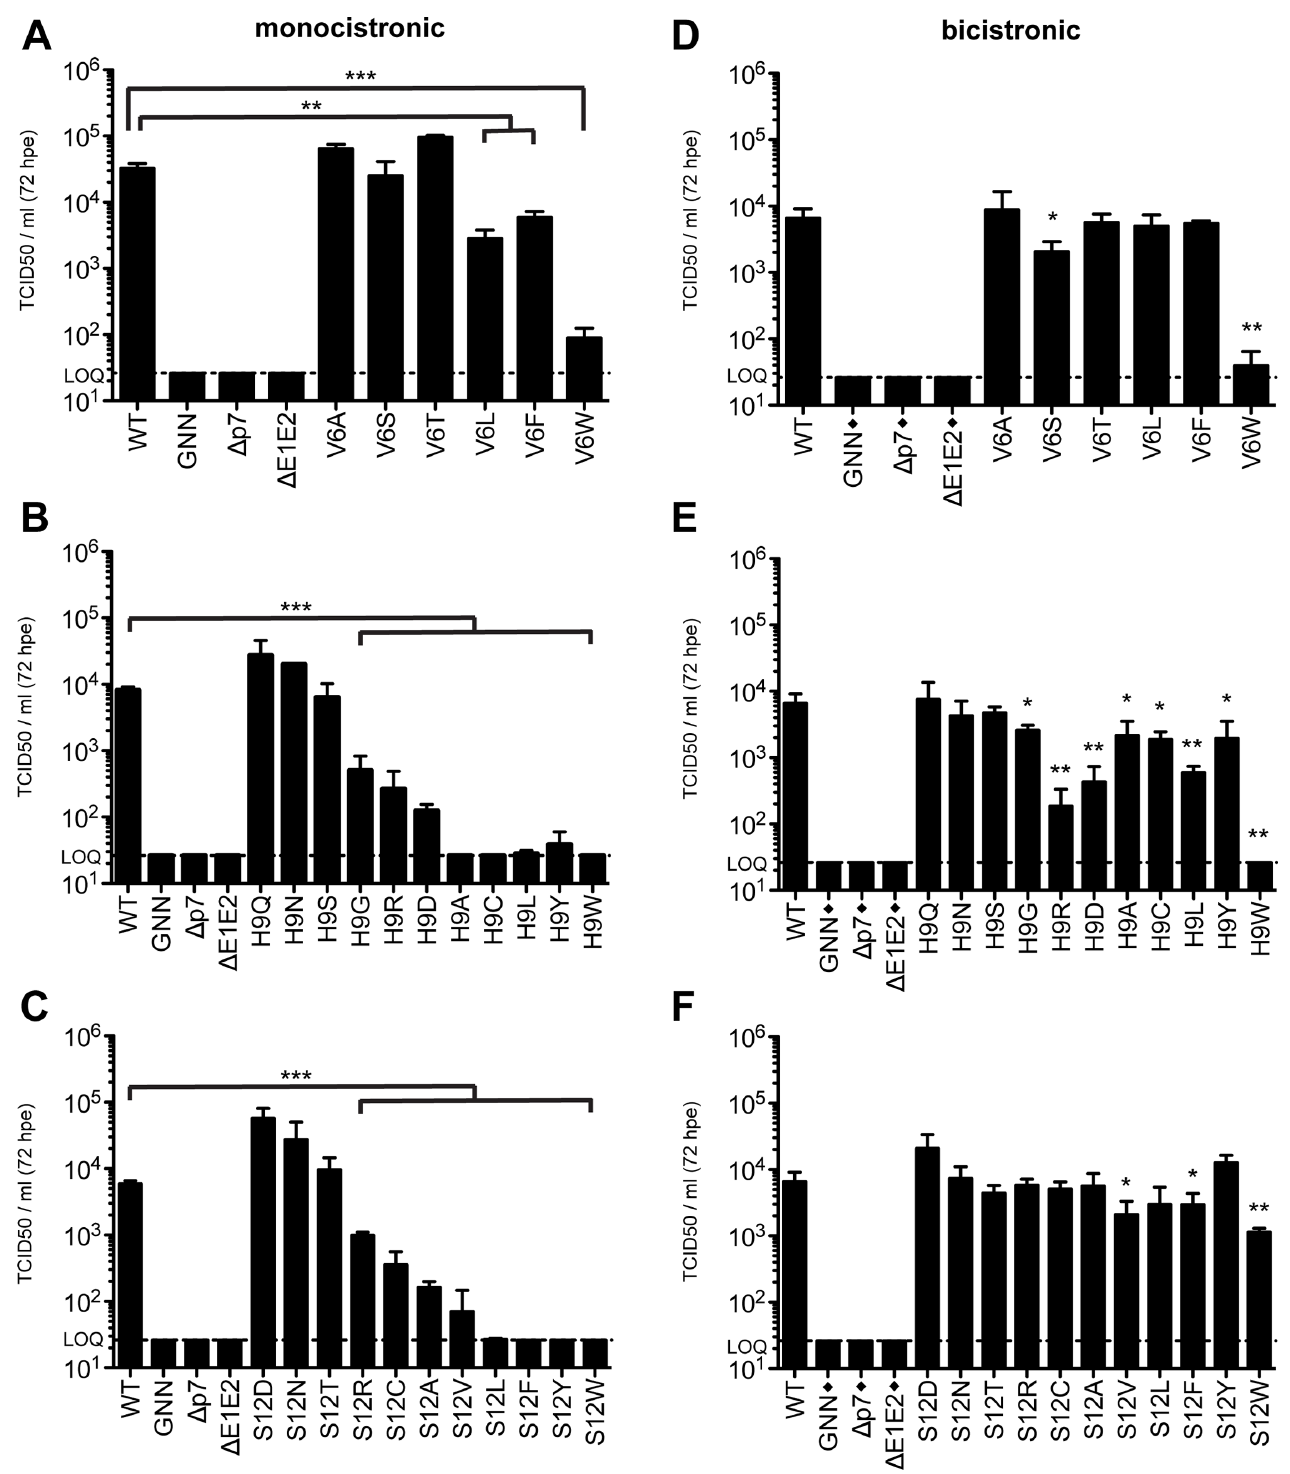
Fig 7. Amino acid requirements at positions 6, 9, and 12. Infectious virus in the supernatants of monocistronic (A, B & C) or bicistronic (D, E & F) p7 mutants quantified by limiting dilution assay on na ï ve Huh-7.5 cells. Mutant viruses yielding significantly less infectious virus production as compared with wild-type were identified using unpaired t-tests. Statistical results are indicated as follows: * p < 0.05, ** p < 0.01 and *** p < 0.001. Black diamond ( ◆ ) indicates that these control viruses are monocistronic. Note that the WT, GNN, Δ p7, and Δ E1E2 titers reported in panels E and F are duplicated from panel D as these viruses were all analyzed in